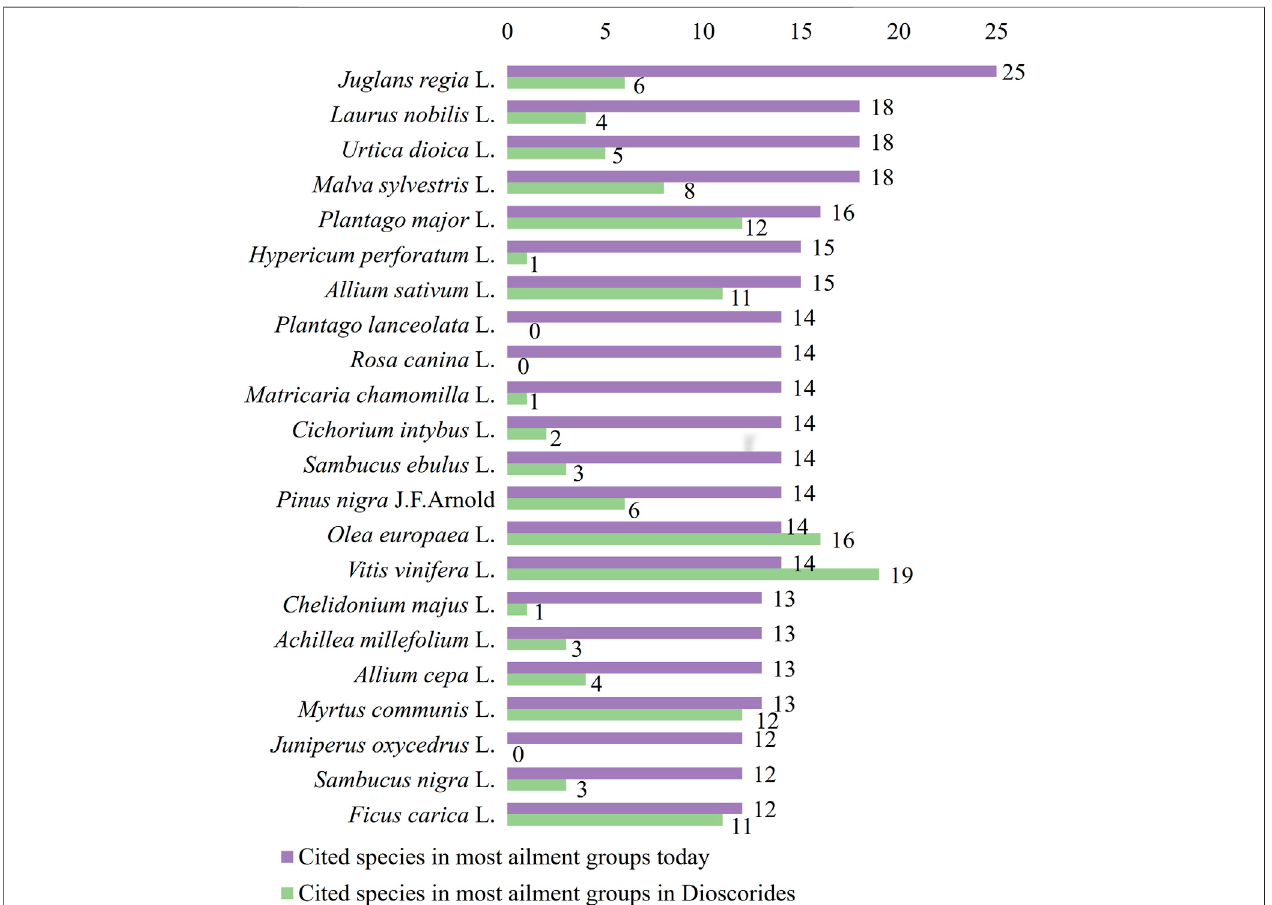
FIGURE 8 | Cited species in most ailment groups. Comparison between contemporary data and Dioscorides.